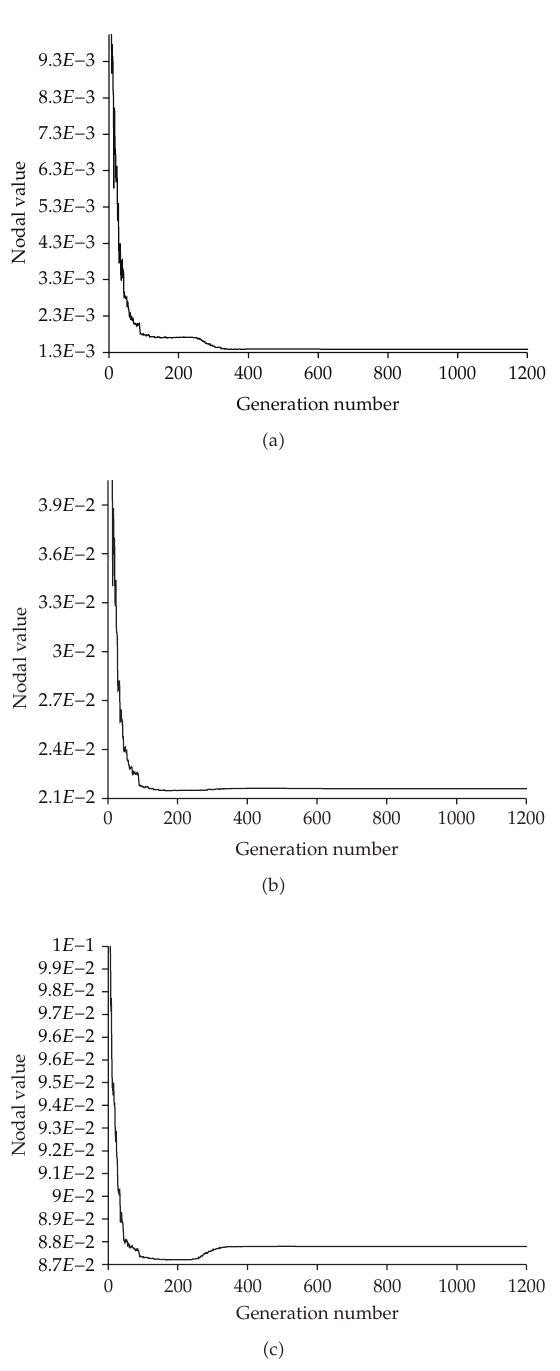
Figure 7: Evolution of the nodal values for Problem 4 of (cid:3) a (cid:4) the second node; (cid:3) b (cid:4) the middle node; (cid:3) c (cid:4) the eighth